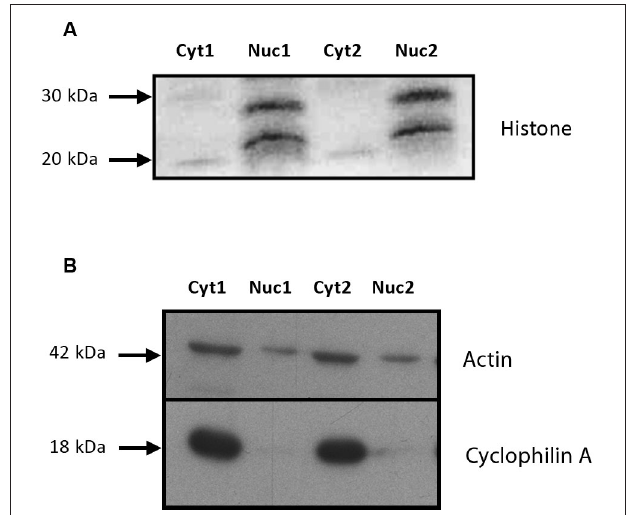
FIGURE 2 | The tissue isolation procedure produced high quality nuclear and cytosolic fractions . (A) Immunoblot of histone proteins (20 and 28 kDa) in the nuclear and cytosolic fractions from the subcellular compartmentalization protocol used to isolate the nuclear material. An anti-histone antibody was used to assess the purity of the fraction. (B) Immunoblot of cyclophilin A and actin (18 and 42 kDa) in the nuclear and cytosolic fractions from the subcellular compartmentalization protocol used to isolate the nuclear material. An anti-cyclophilin A antibody was used to assess the purity of the fraction. This protocol was based on the technique used by Fumagalli et al. (2010). Cyt: cytosolic fraction, Nuc: nuclear fraction. 1 and 2 comprise for two independent samples (unstressed and stressed animals euthanized at 60